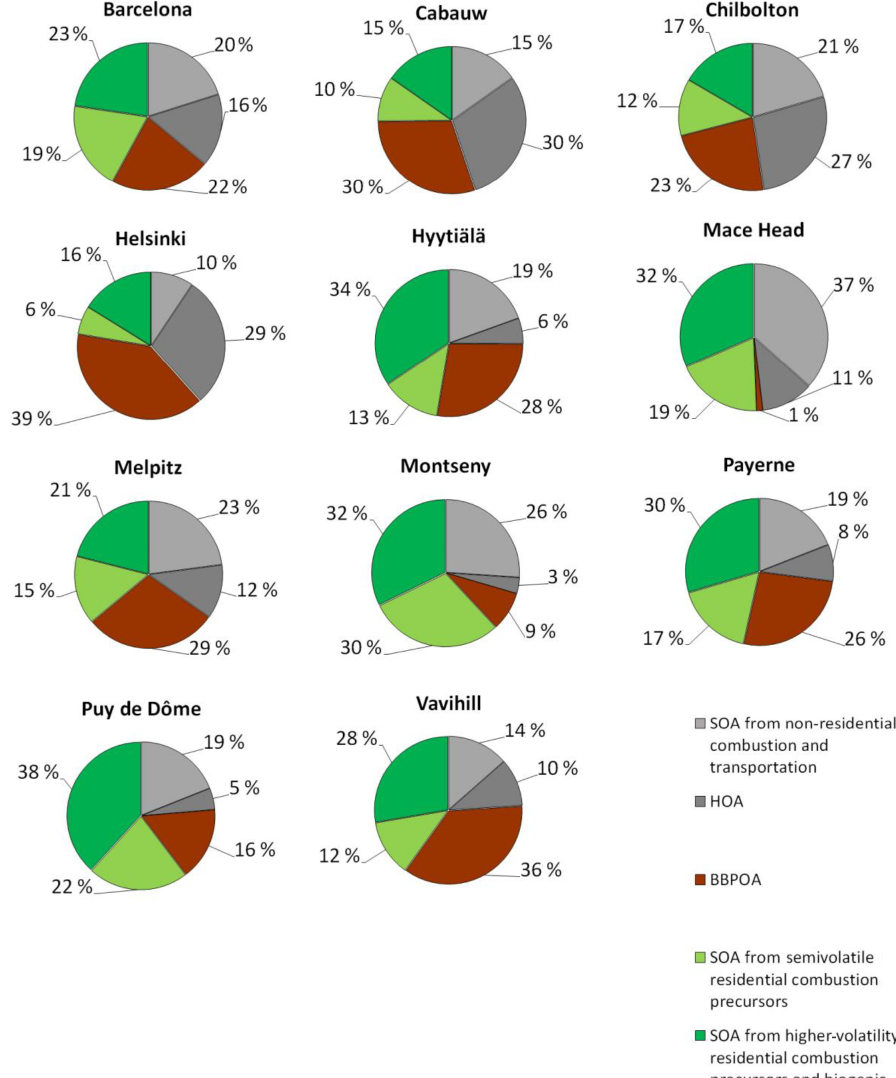
Figure 12. Average modelled composition of OA at the 11 AMS sites for the period between 25 February and 26 March 2009.